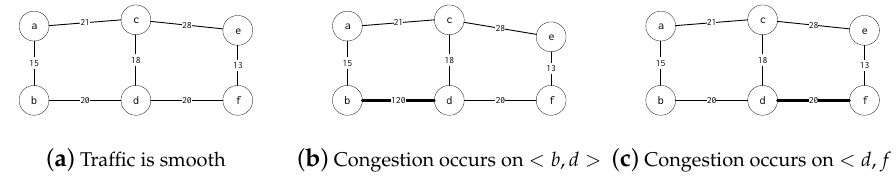
Figure 3. Example of state transformation of the road networks when road jam